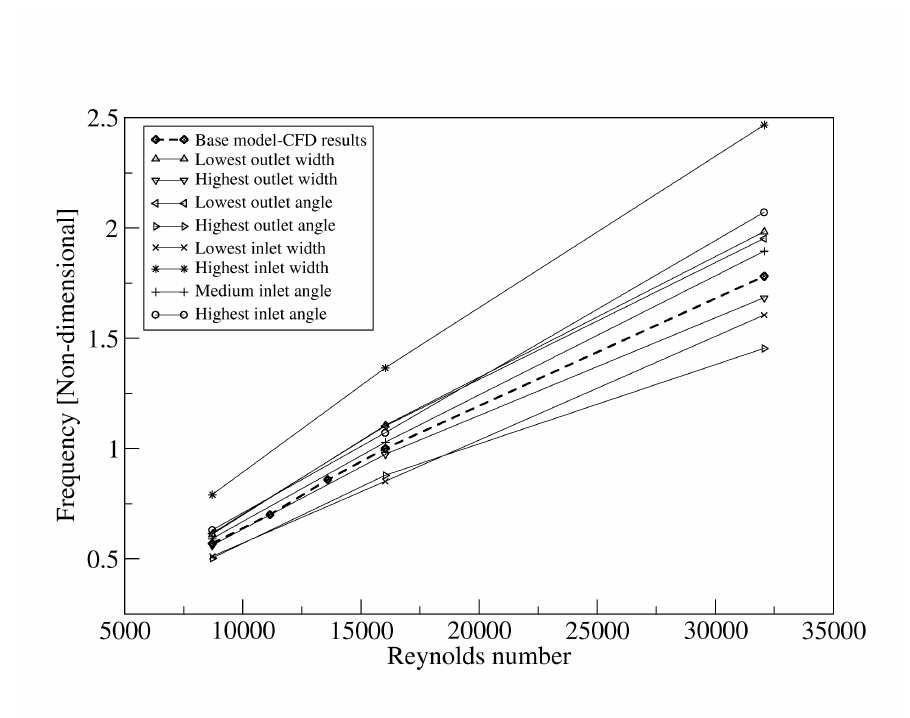
Figure 16. Relation Reynolds number versus mass flow output frequency, for all dimensional modifications